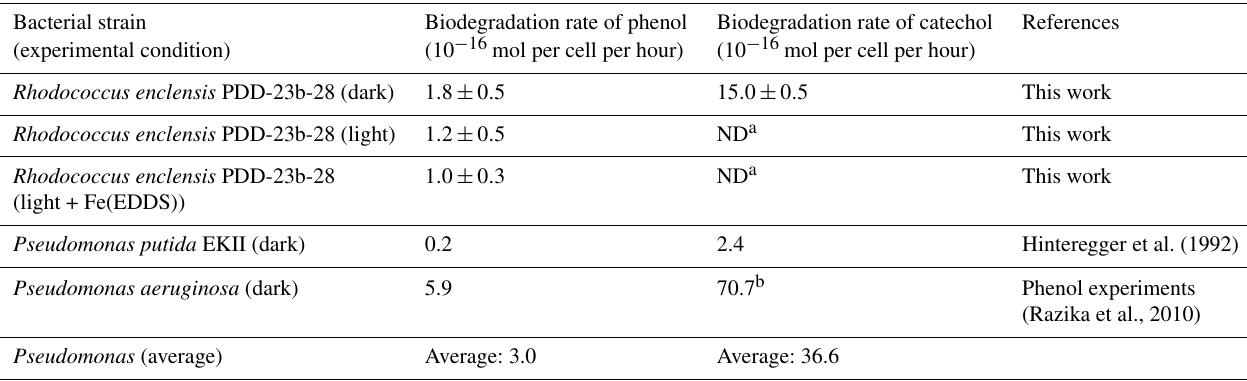
Table 2. Biodegradation rates (mol per cell per hour) of catechol and phenol of Rhodococcus and Pseudomonas strains normalized to the exact number of cells present in the incubations. The calculations of biodegradation rates for the Pseudomonas strains are detailed in Sect. S1. Bacterial